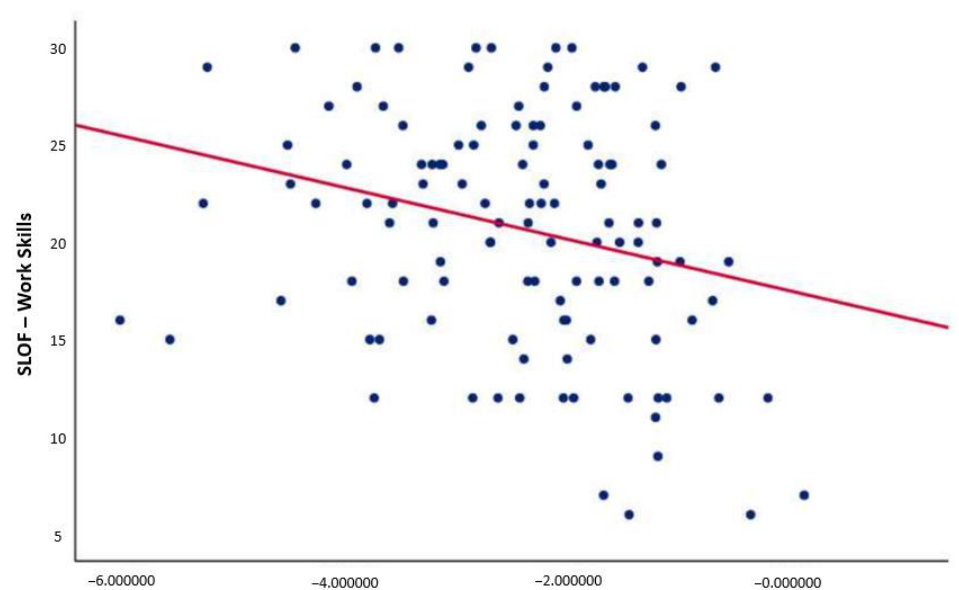
Figure 2. Correlation between p-MMN amplitude and the “work skills” domain of the SLOF scale. p-MMN, pitch deviant mismatch negativity. Negative correlation between p-MMN amplitude and the “work skills” domain of the SLOF scale (r = − 0.257; p = 0.005) (significant p -value threshold 0.008). This correlation remained significant after controlling for positive, negative, and disorganized symptoms; depression; neurocognition; and global parkinsonism.